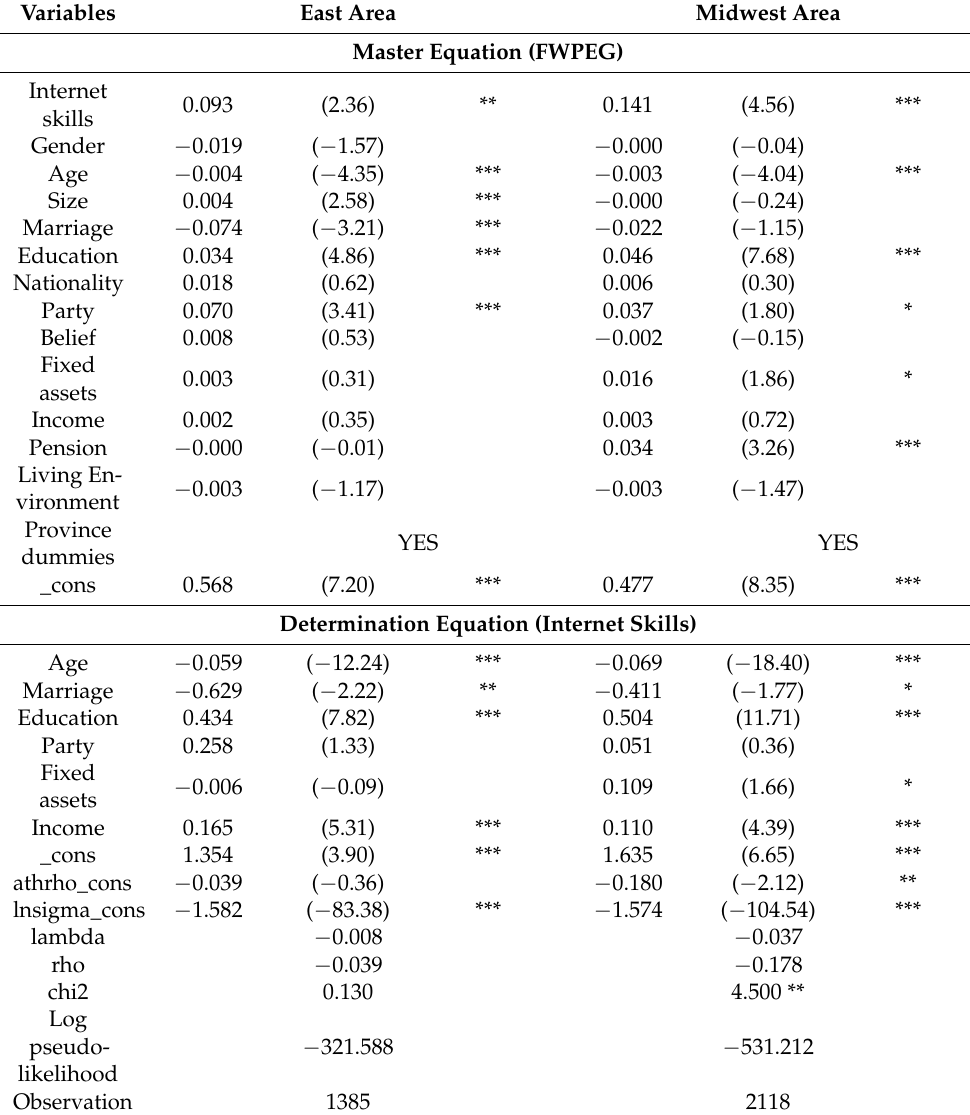
Table 7. Comparison of maximum likelihood estimation results in eastern and central-western